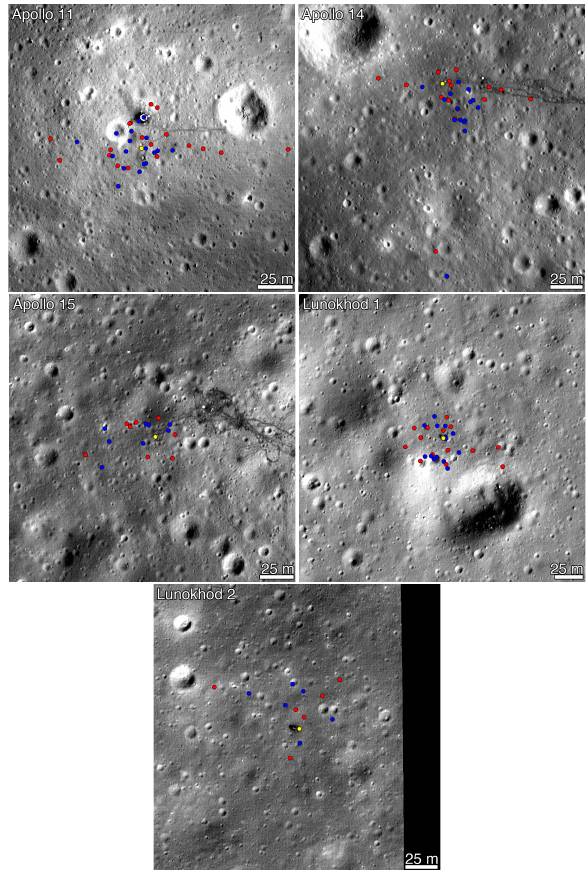
Figure 4. Distribution of the calculated retroreflectors locations before (red) and after (blue) the absolute point correction, compared to the actual retroreflector location (yellow) The five retroreflectors were located in 62 NAC frames, and the true instrument pointing was derived for each of those frames.